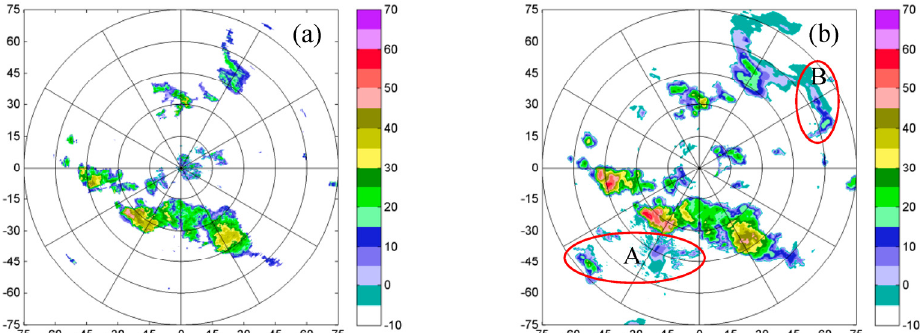
Figure 5. ( a ) Original reflectivity at X-band for convective cloud on 19 June 2015; ( b ) the intrinsic reflectivity at X-band. The color shade guide is the reflectivity factor in unit of dBZ and the X-Y axis is the range in unit of km in the figure and the following figures.